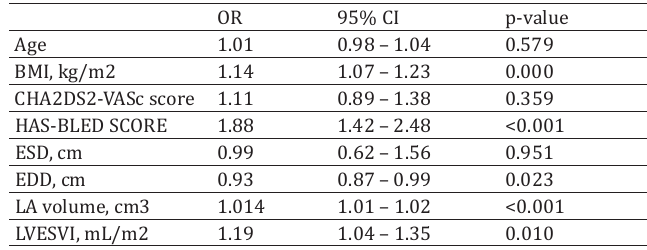
Multivariate analysis of predictors of left atrial appendage thrombus according to CT (N=292)